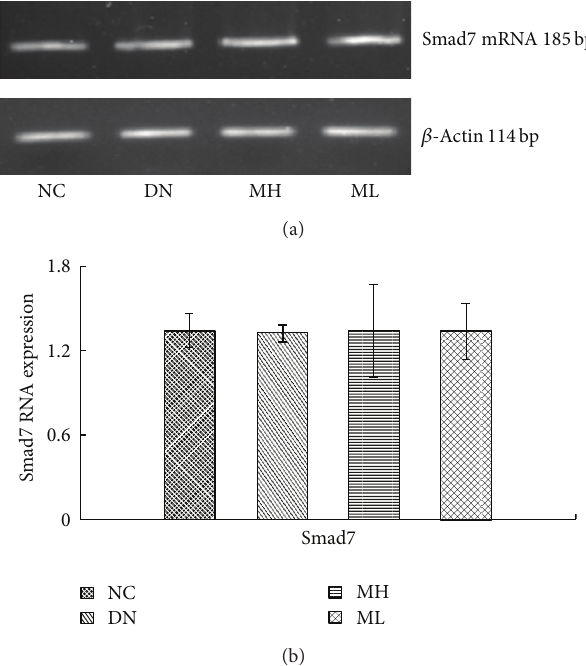
Figure 6: Smad7 mRNA levels by Real-Time fluorescent quantita- tive PCR in each group. (a) RT-PCR strip chart. (b) The gray graph shows the relative statistical values of the mRNA levels. There was not significant change of Smad7 mRNA levels in the different